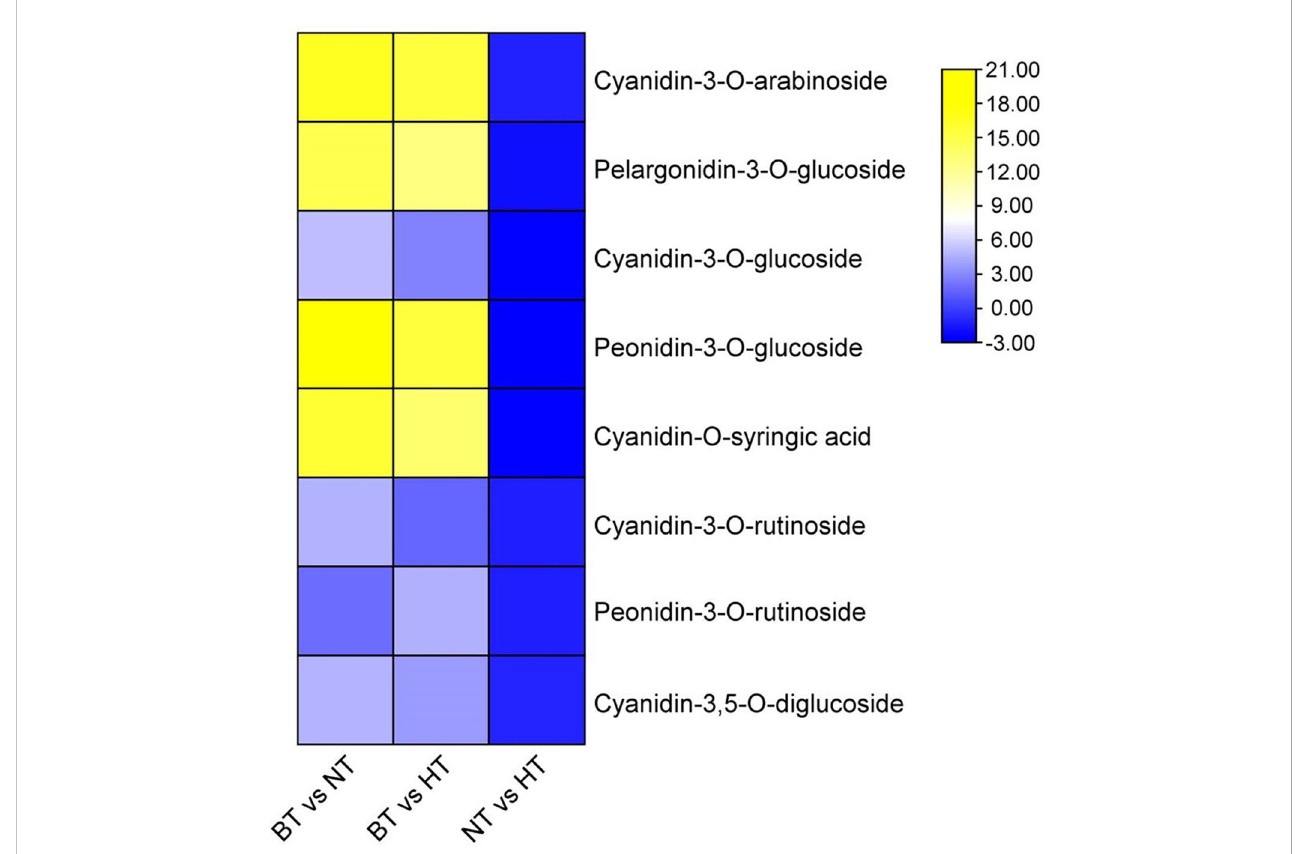
FIGURE 2 Differential accumulation of anthocyanin monomers in sweet cherry peel. Anthocyanin monomers were visualized as a heat map based on log 2 (fold change) obtained from comparisons among different